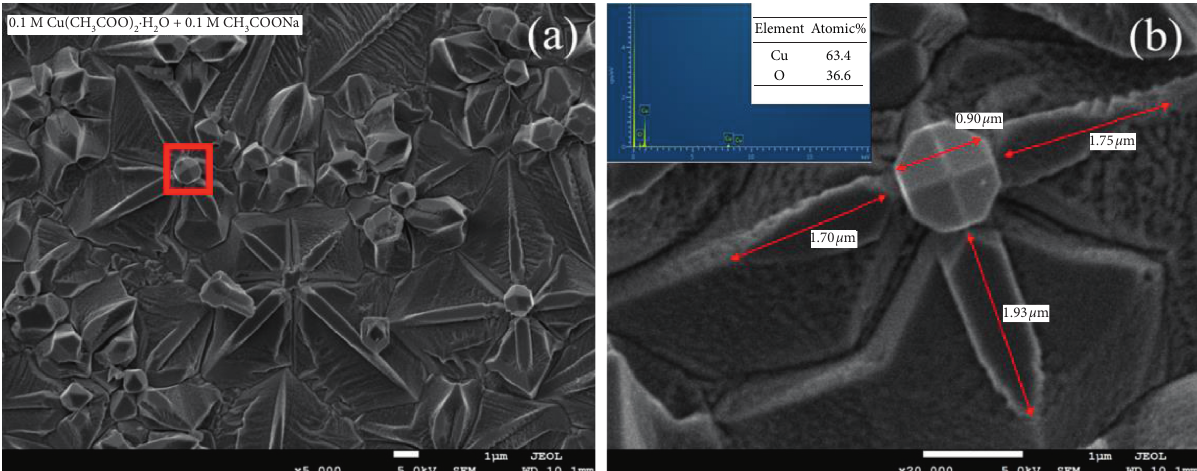
Figure 10: SEM images of electrodeposition of the CuO-Cu ratios.